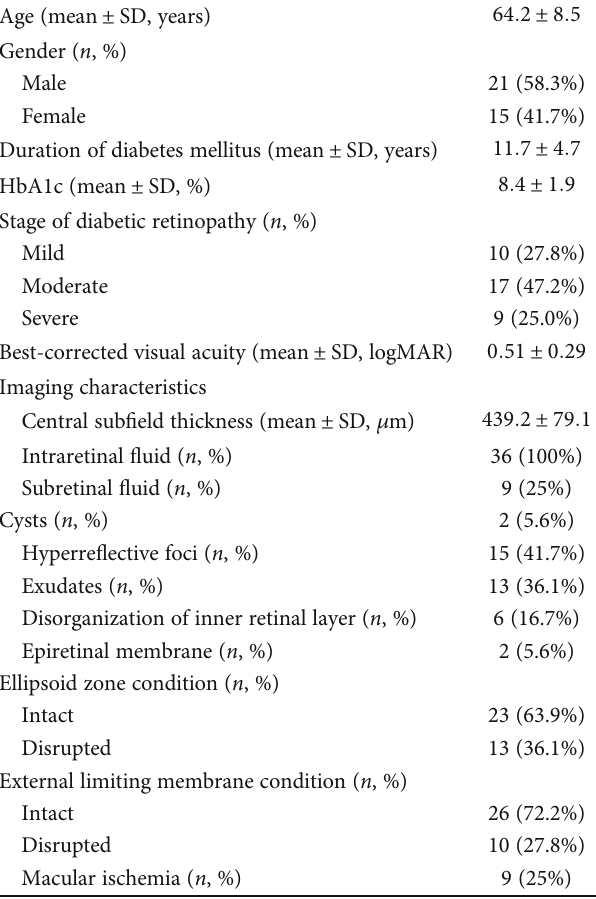
Table 2: Association between laboratory variables and variables are summarized as median (IQR: interquartile range).